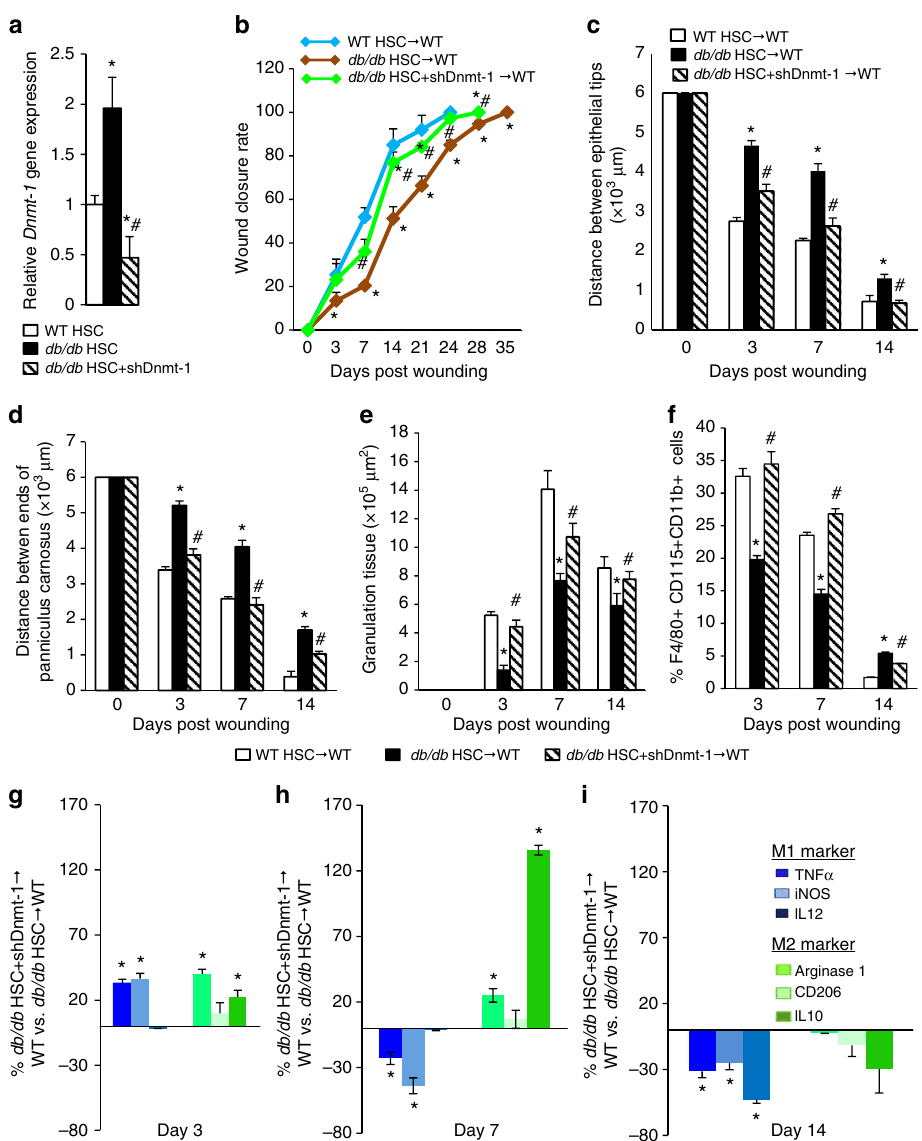
Fig. 6 Knockdown of Dnmt1 in db/db HSCs increases wound closure rate. a qRT-PCR quanti fi cation of Dnmt1 expression ( n = 6, * p < 0.05 vs. WT HSC, # p < 0.05 vs. db/db HSC). b Wound closure rate measurement ( n = 8, * p < 0.05 vs. WT HSC → WT, # p < 0.05 vs. db/db HSC → WT). c – e Histological quanti fi cation of distance between epithelial tips/ends of panniculus carnosus and granulation tissue ( n = 4, ** p < 0.05 vs. W T HSC → WT, # p < 0.05 vs. db/db HSC → WT). f Quanti fi cation of macrophage concentration in the cutaneous wounds by fl ow cytometry ( n = 6, * p < 0.05 vs. WT HSC → WT, # p < 0.05 vs. db/db HSC → WT). g – i Quanti fi cation of M1/M2 polarization in cutaneous wounds by fl ow cytometry. ( n = 6, # p < 0.05 vs. db/db HSC →